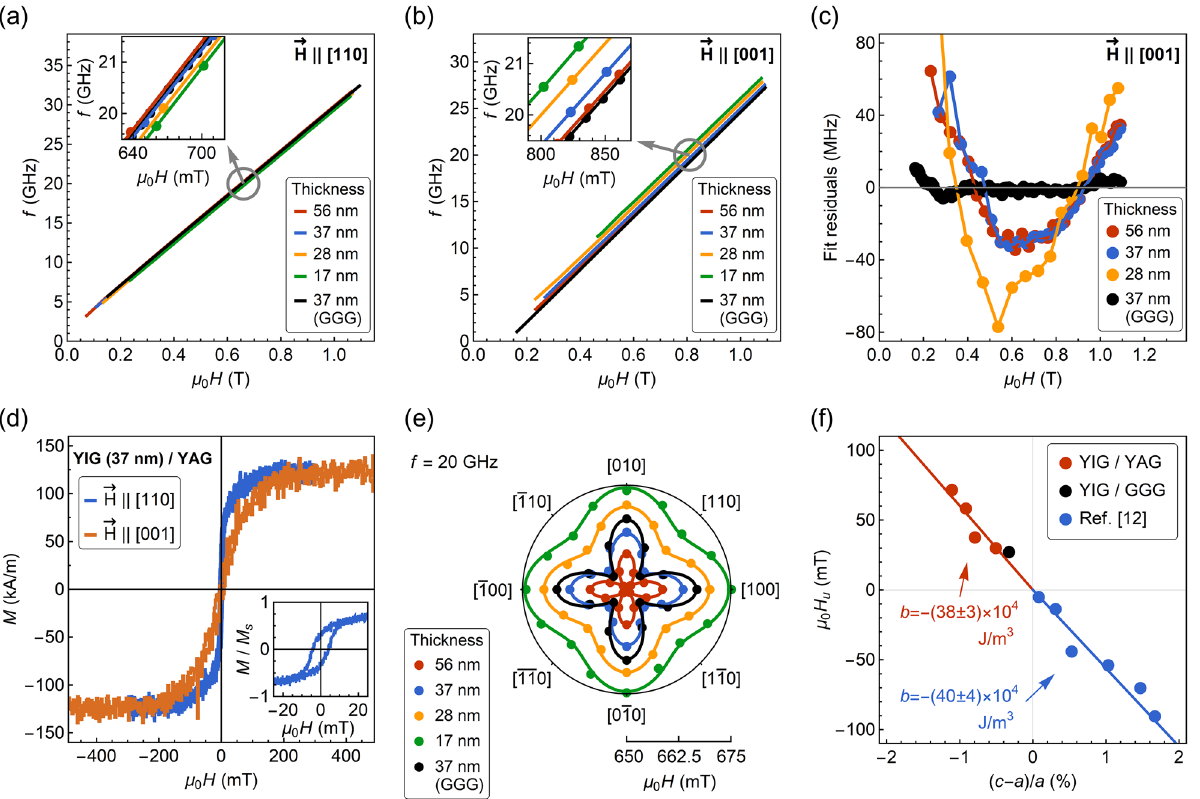
Figure 2. ( a ) and ( b ) show frequency versus resonance field dependencies for magnetic field applied along in-plane [110] and out-of-plane [001] directions, respectively. The insets display enlarged regions near f = 20 GHz. ( c ) Fit residuals obtained from a fitting with Eq. (4) for the out-of-plane measurement configuration. Due to larger linewidth and lower signal-to-noise ratio, the residuals for the 17 nm thick film varied randomly in the range of ‒ 45 to 60 MHz, and therefore, have been omitted. ( d ) Hysteresis loops of 37 nm thick film deposited on YAG. Diamagnetic contribution from the substrate was subtracted from the raw data. Inset shows the enlarged view at the low fields for (cid:31) H || [110]. ( e ) In-plane angular dependence of the resonance field recorded at a constant frequency f 20 GHz. ( f ) Out-of-plane uniaxial anisotropy field as a function of the = tetragonal distortion of YIG unit